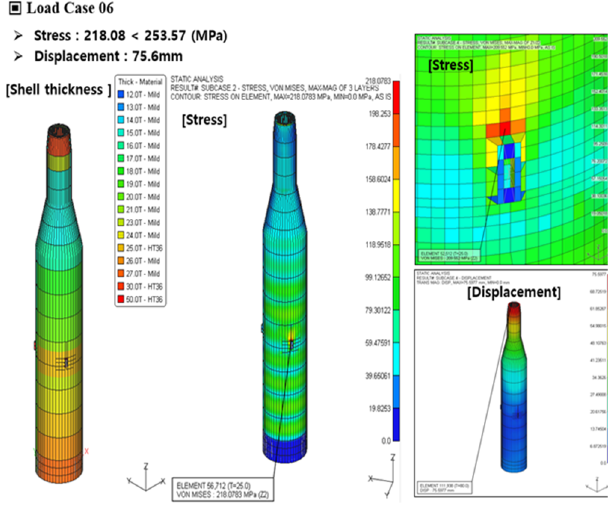
Figure 14. Three-dimensional finite element model and results of a spar structure.